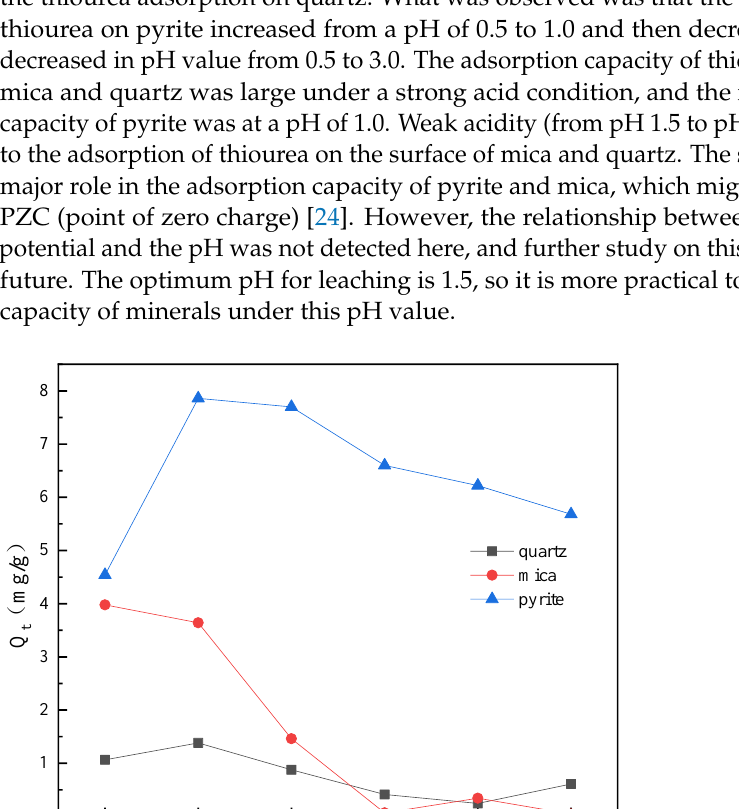
Figure 2. Effect of pH values on the adsorption of thiourea on quartz, mica, and pyrite. 3.3. Adsorption Isotherms The initial thiourea concentration is an important parameter because this factor can reflect the adsorption isotherms of minerals for a given initial temperature. Hence, the adsorption of thiourea onto the minerals at different initial thiourea concentrations was